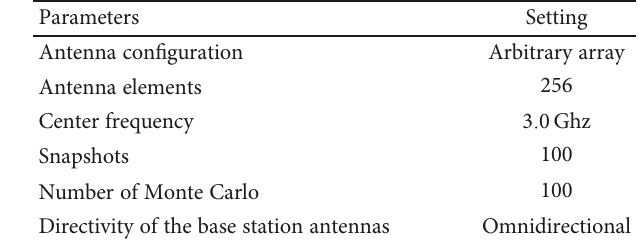
Table 3: Simulation